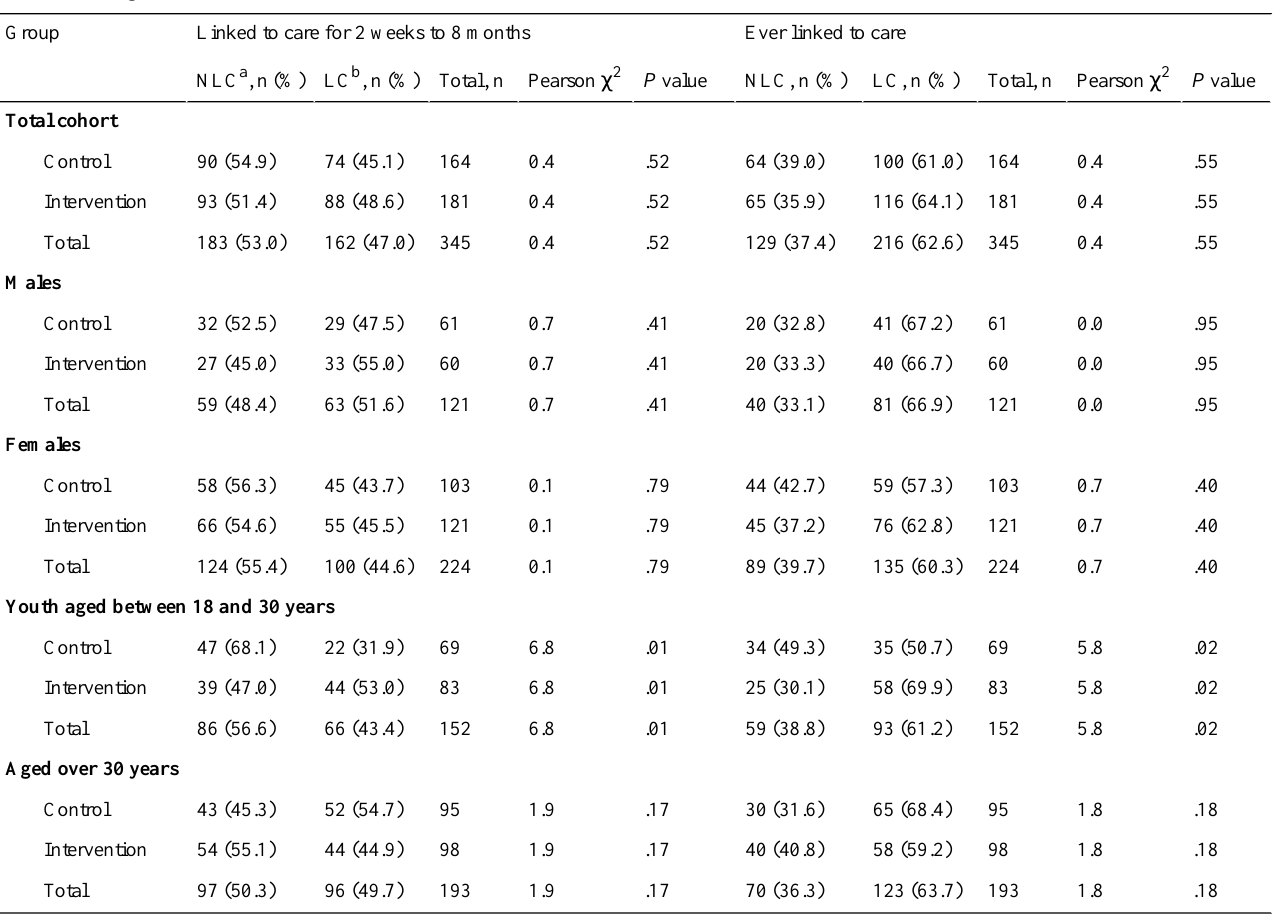
Table 2. Linkage to care.